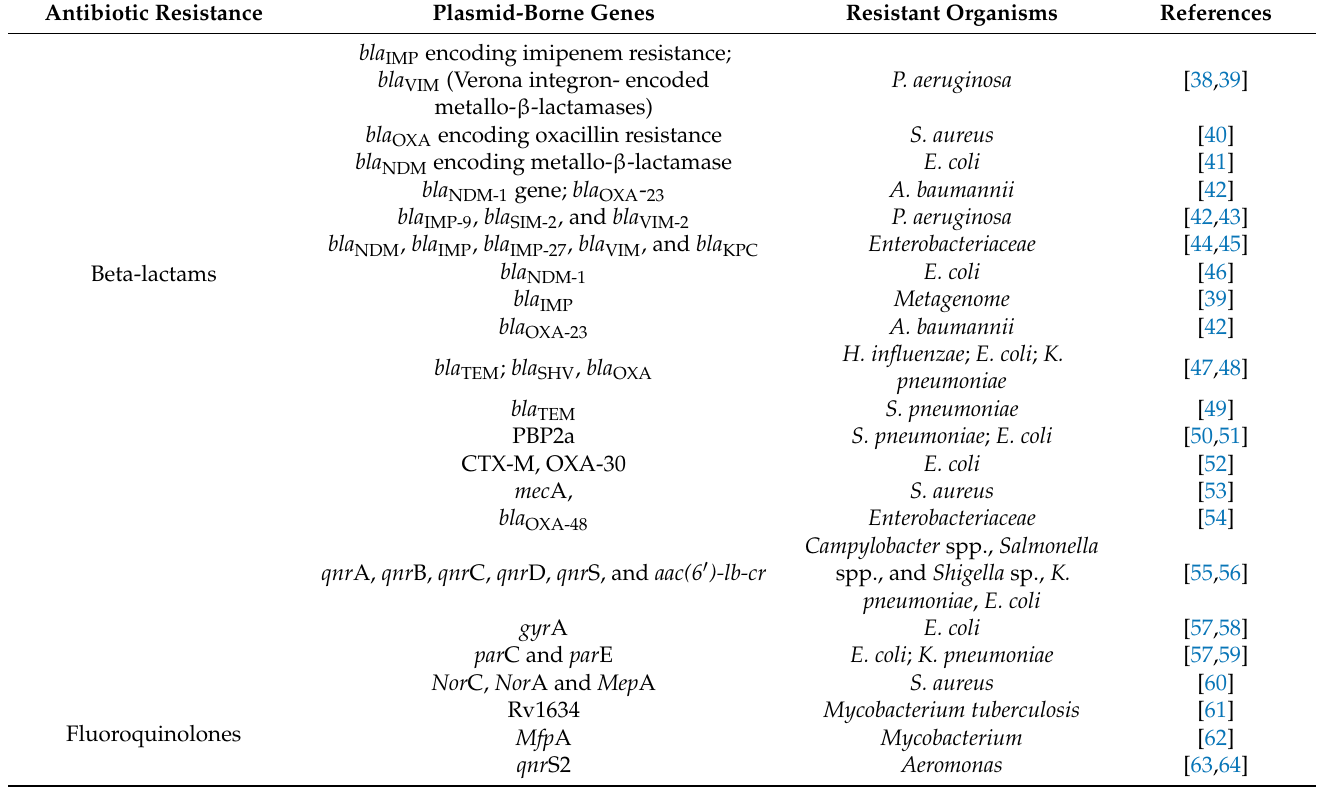
Table 2. Plasmid-borne genes for antibiotic resistance in different organisms. Antibiotic Resistance Plasmid-Borne Genes Resistant